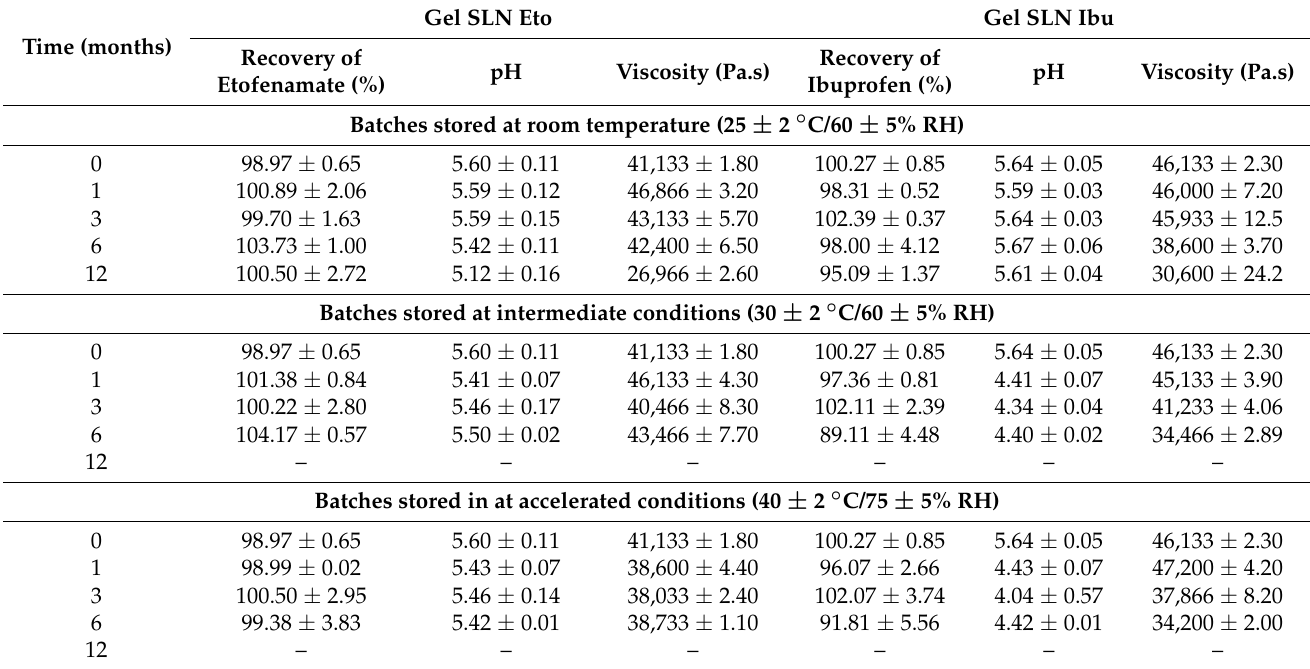
Table 2. Physicochemical stability of drug-loaded hydrogel batches: etofenamate-SLN hydrogel (Gel SLN Eto)